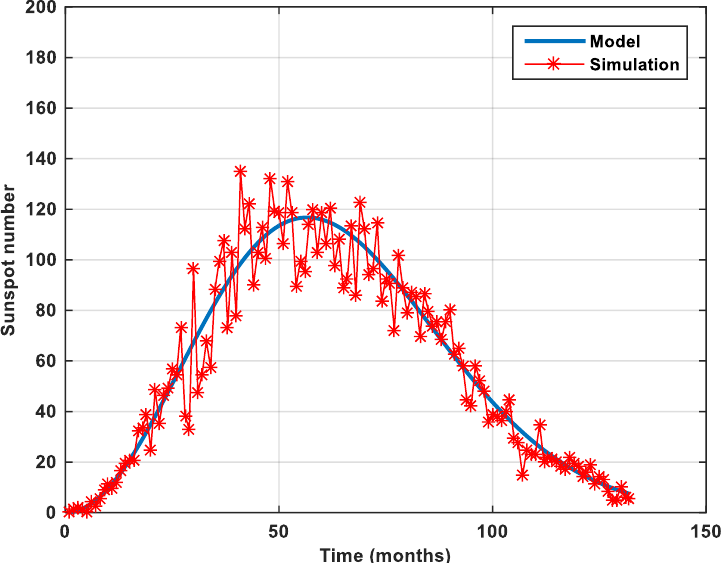
Figure-10. Simulated sunspot cycle 20 by the